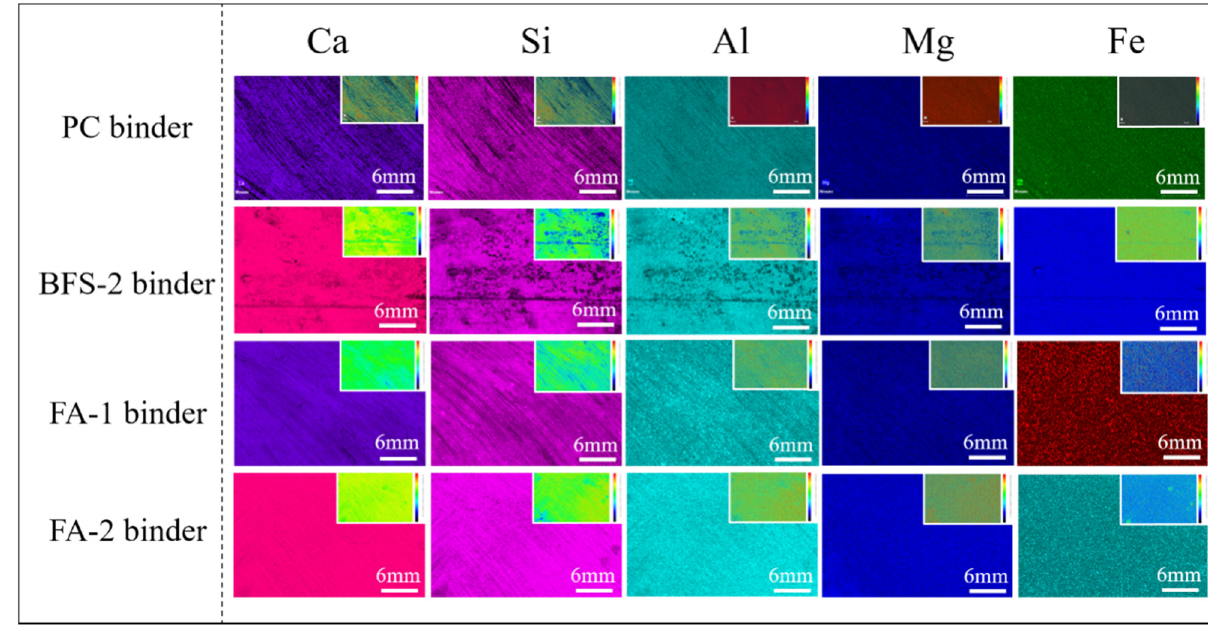
Figure 10: Element distribution images of inorganic